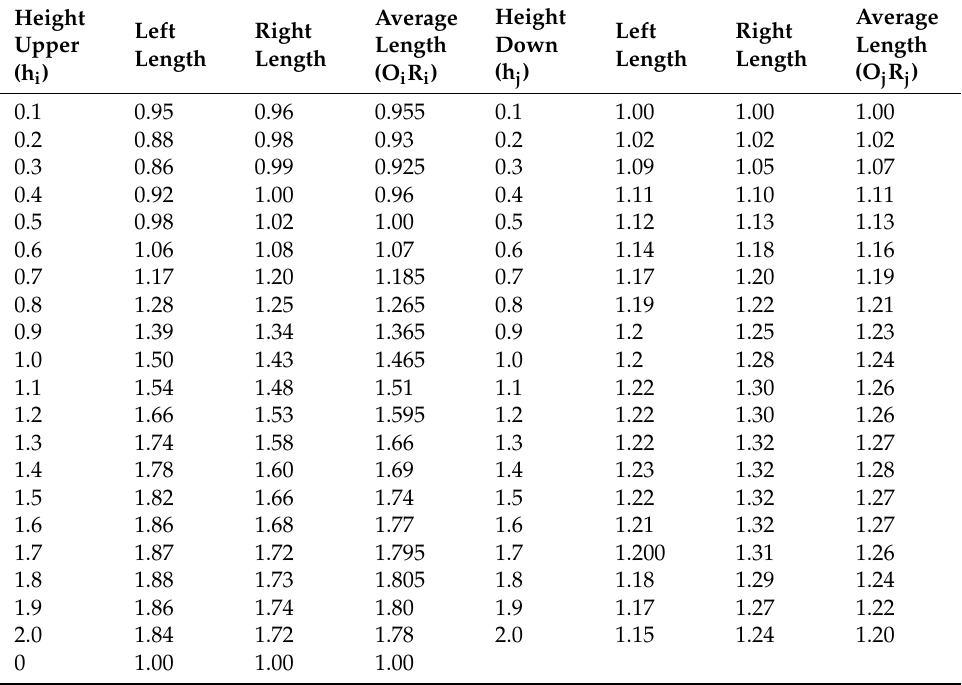
Table A3. Cross-sectional profile of case S4 weld seam. (Unit: mm).